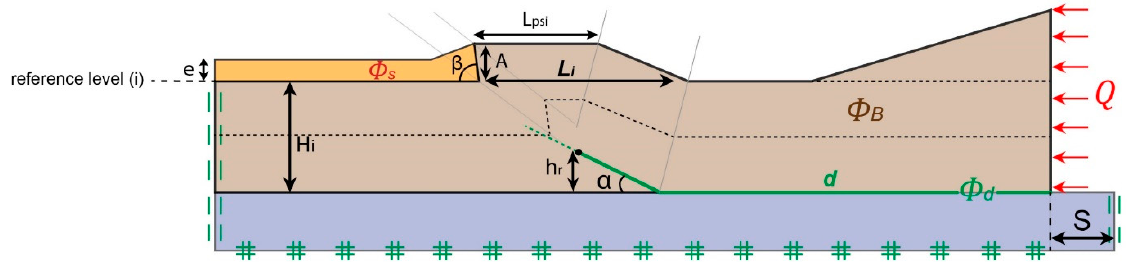
Figure 2. Schematic base model geometry at an intermediary stage. H i : initial pre tectonic thickness; L psi : length of the fold top; L i : horizontal length at the base of the fold; A: amplitude of the front limb of the fold; h r : height of the fault tip; α : angle of the thrust; β : angle of the fold front limb; S: shortening; e: thickness of the syn-tectonic layer; ϕ B : internal friction of the bulk material; ϕ d : internal friction of the decollement (d, green line); ϕ S : internal friction of the syn-tectonic material. Green symbols correspond to the movements allowed at the border of the section.